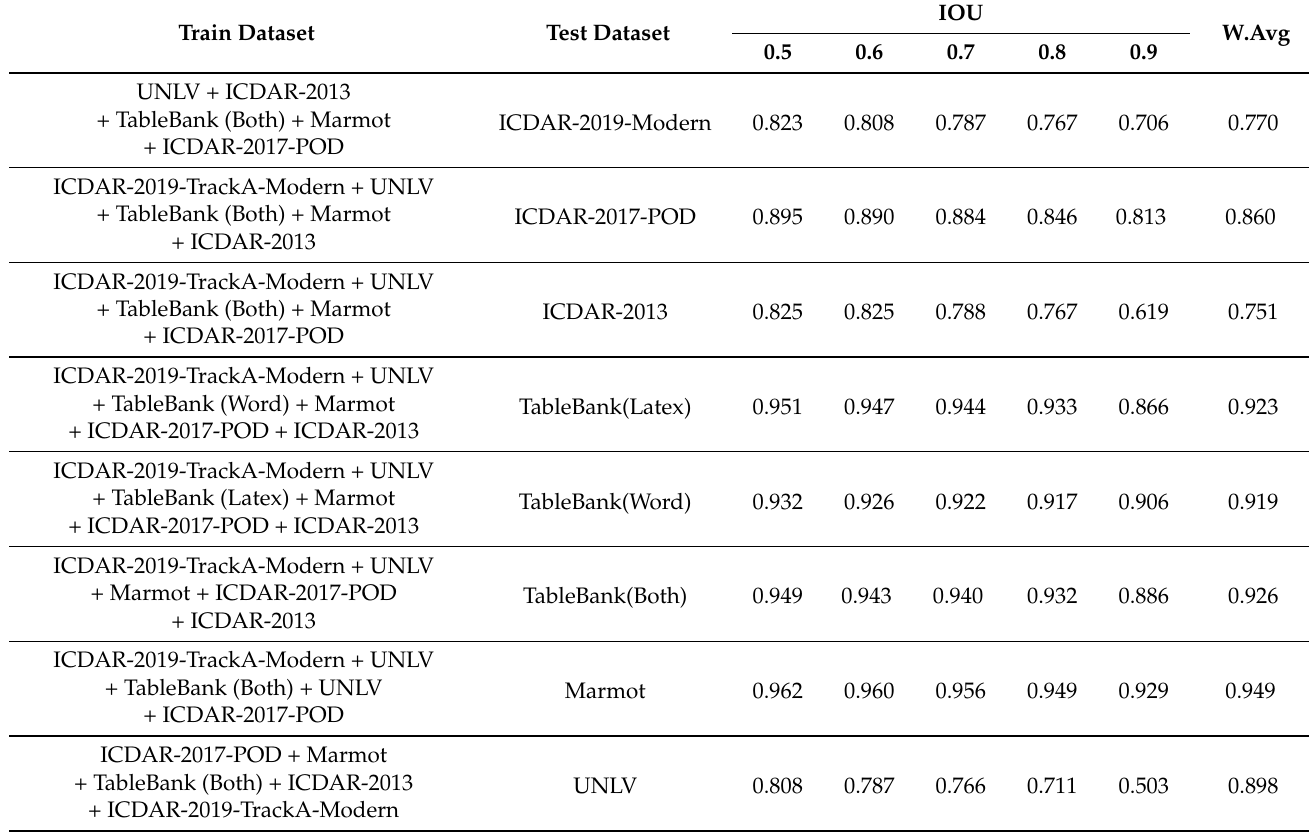
Table 7. The results of our leave one out dataset strategy. HybridTabNet achieved state-of-the-art performance on the Marmot dataset. W.Avg denotes the weighted-average of the respective measure on the IoU threshold. Train